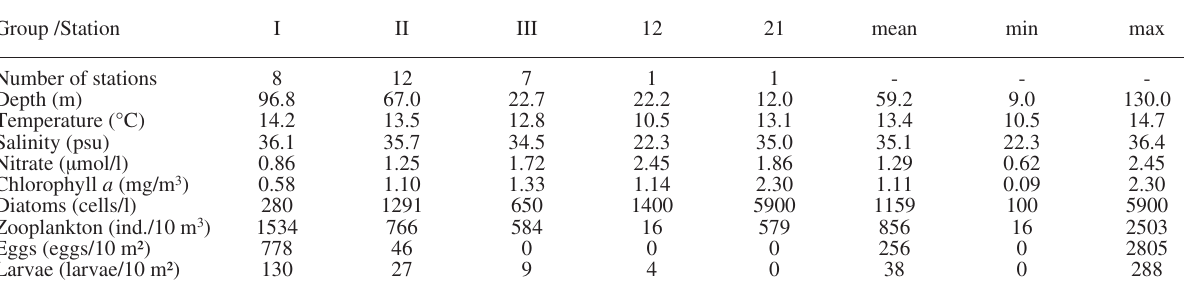
Table 2. – mean values of environmental parameters and sardine egg and larval abundance by group and min-max for all stations. Group /station